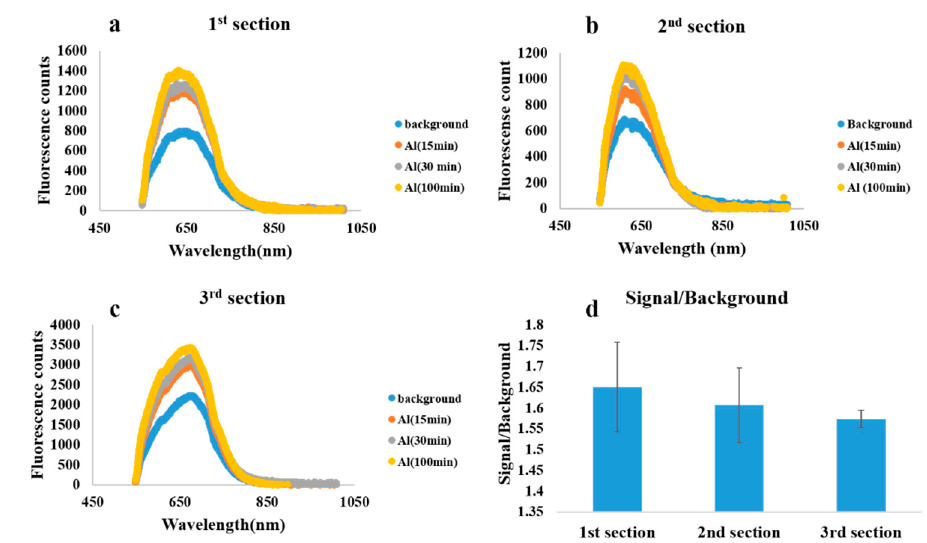
Figure 2. Fluorescence counts for a surface functionalized ECF (at plasma power of 25 W)-based aluminium sensor. ( a – c ) Each plot corresponds to a different section of the same fiber. Blue curves correspond to background fluorescence from the fluorophore-coated fiber. Orange, grey and yellow curves were recorded at 15, 30 and 100 min after exposing the fiber to 1 mM aluminium ion solution. ( d ) Bar plot corresponds to the average of signal-to-background ratio recorded at 100 min for sections (1st, 2nd and 3rd) of 3 fibers each.